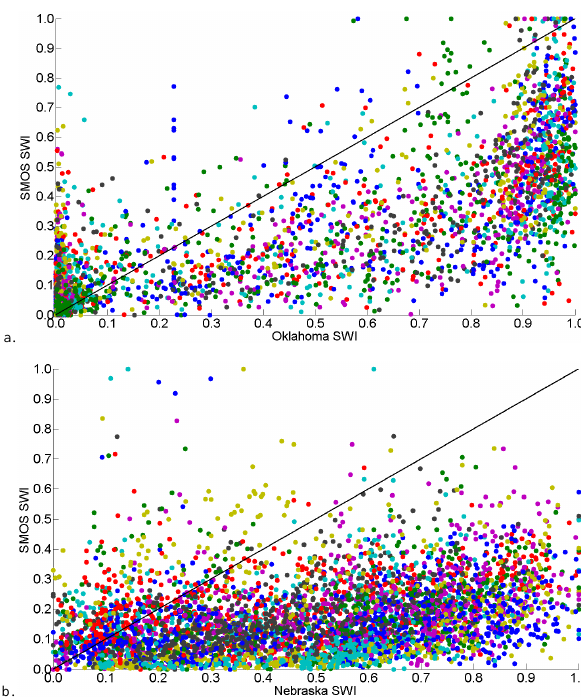
Figure 12 . Performance (NS score) of the exponential filter method when estimating root zone SWI from SMOS surface data as a function of T-parameter values. The top plot shows results for Oklahoma and the bottom shows results for Nebraska. NS scores are calculated between SMOS- estimated root zone soil moisture and in situ root zone soil moisture.